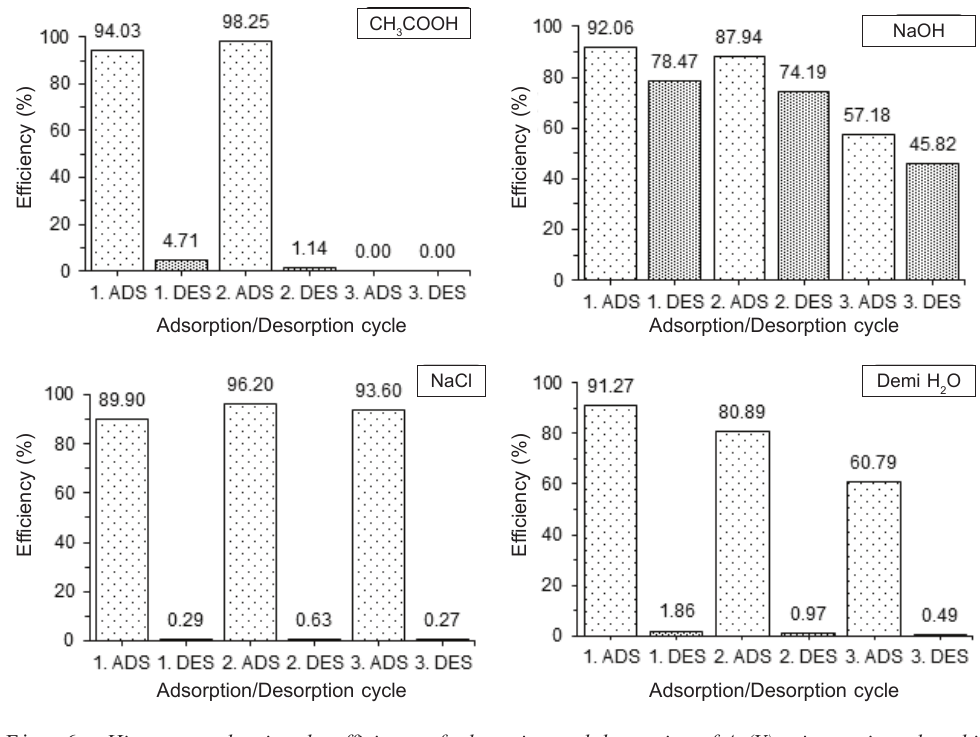
Fig. 6 – Histograms showing the efficiency of adsorption and desorption of As(V) using various desorbing agents (As(V) initial concentration 1000 μg L −1 , volume of solution 0.1 L, contact time 120